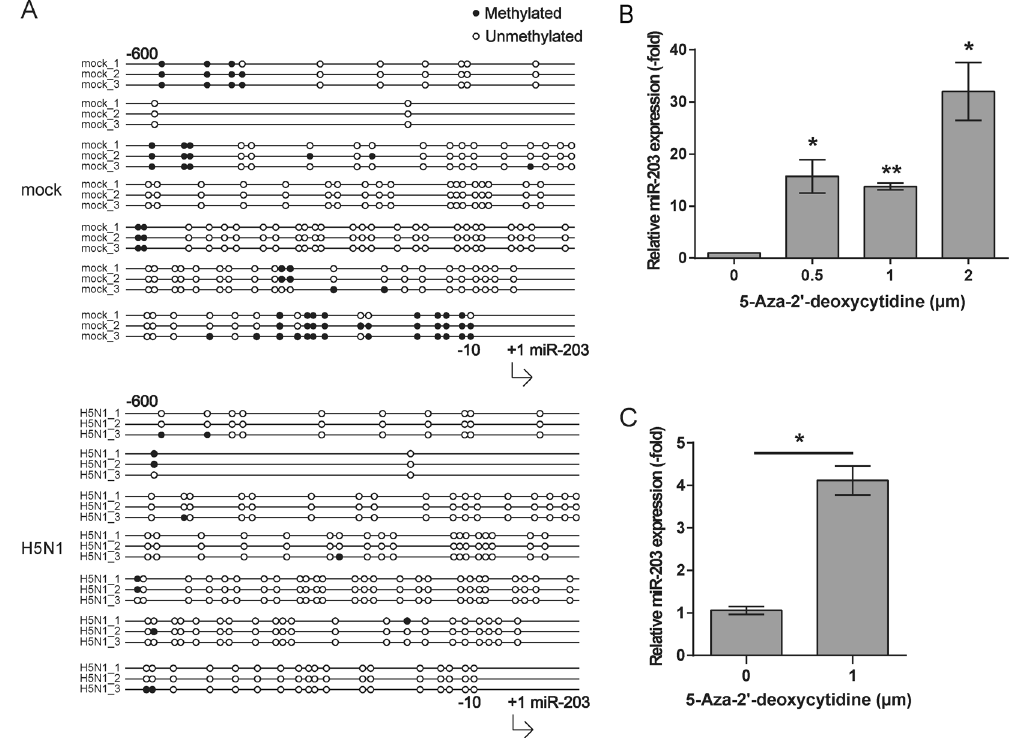
Figure 3. IAV-mediated demethylation of the miR-203 promoter region up-regulates expression of miR-203. ( A ) Bisulfite sequencing PCR of the miR-203 promoter region was performed in A549 cells mock-infected or infected with H5N1 (MOI = 2) viruses for 24 h. The sequenced region covered − 600 to − 10 bp within the miR- 203 promoter region. Three lines denote three replicates in per group. Open circles, unmethylated; solid circles, methylated. ( B ) A549 cells were treated for 48 h with 5-aza-2 ′ -deoxycytidine, a methylation inhibitor, at a final concentration of 0.5, 1, or 2 μ M, and total RNA was purified to analyze abundance of miR-203 by quantitative real-time PCR (qPCR). ( C ) Vero cells were treated for 48 h with 5-aza-2 ′ -deoxycytidine (final concentration, 1 μ M) and total RNA purified. The abundance of miR-203 was measured by qPCR. Data are expressed as the mean + SD of three independent experiments. * p < 0.05; ** p < 0.01; and *** p < 0.001 (Student’s t